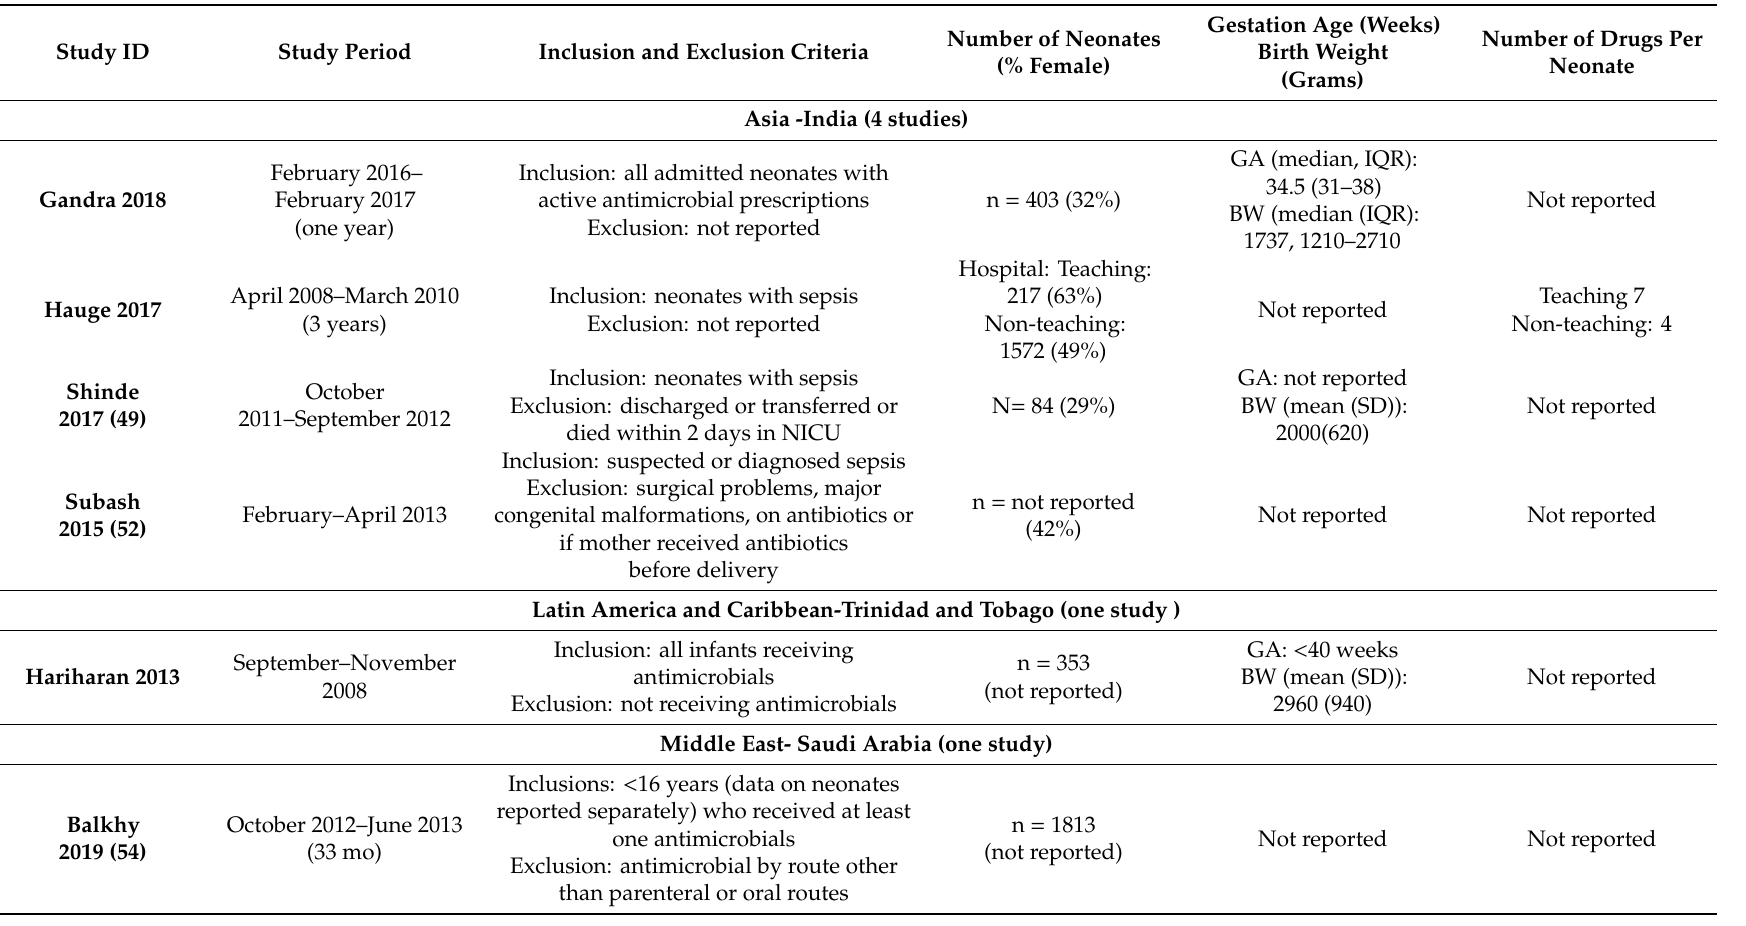
Table A8. Studies of drug utilization on antibiotics only (11